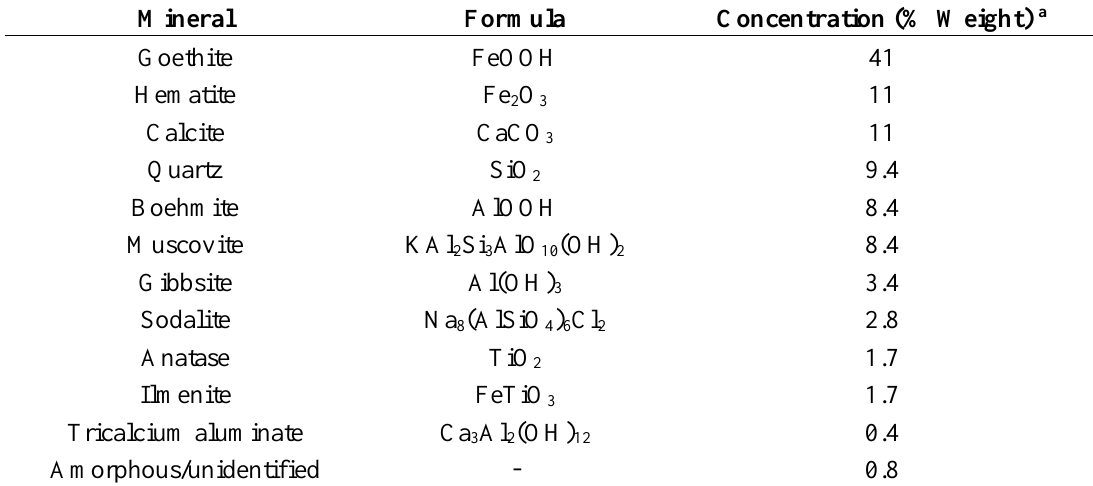
Table 1. Mineral concentrations in bauxite residue prior to hydrothermal treatment, as determined by quantitative mineral analysis by Rietveld refinement of an X-ray diffraction